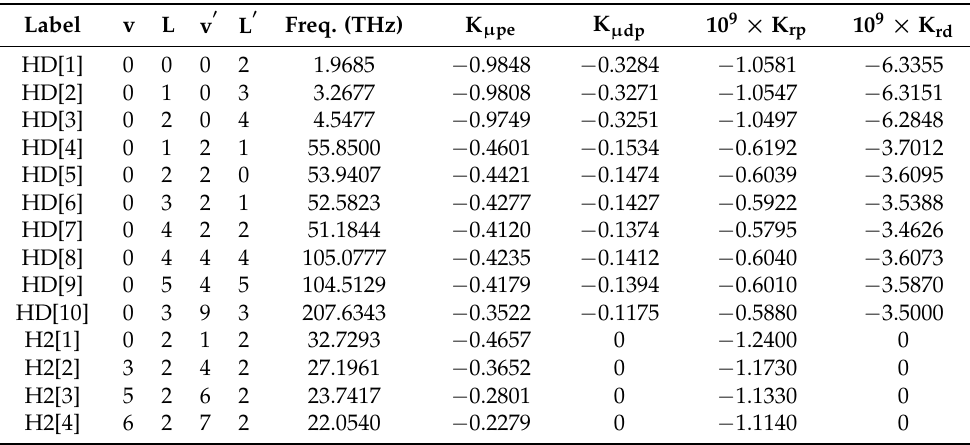
Table 4. Selected rotational and rovibrational two-photon transitions of HD + and H 2+ : frequencies and sensitivity coefficients to constants used in adjustments. Data for H 2+ is taken from